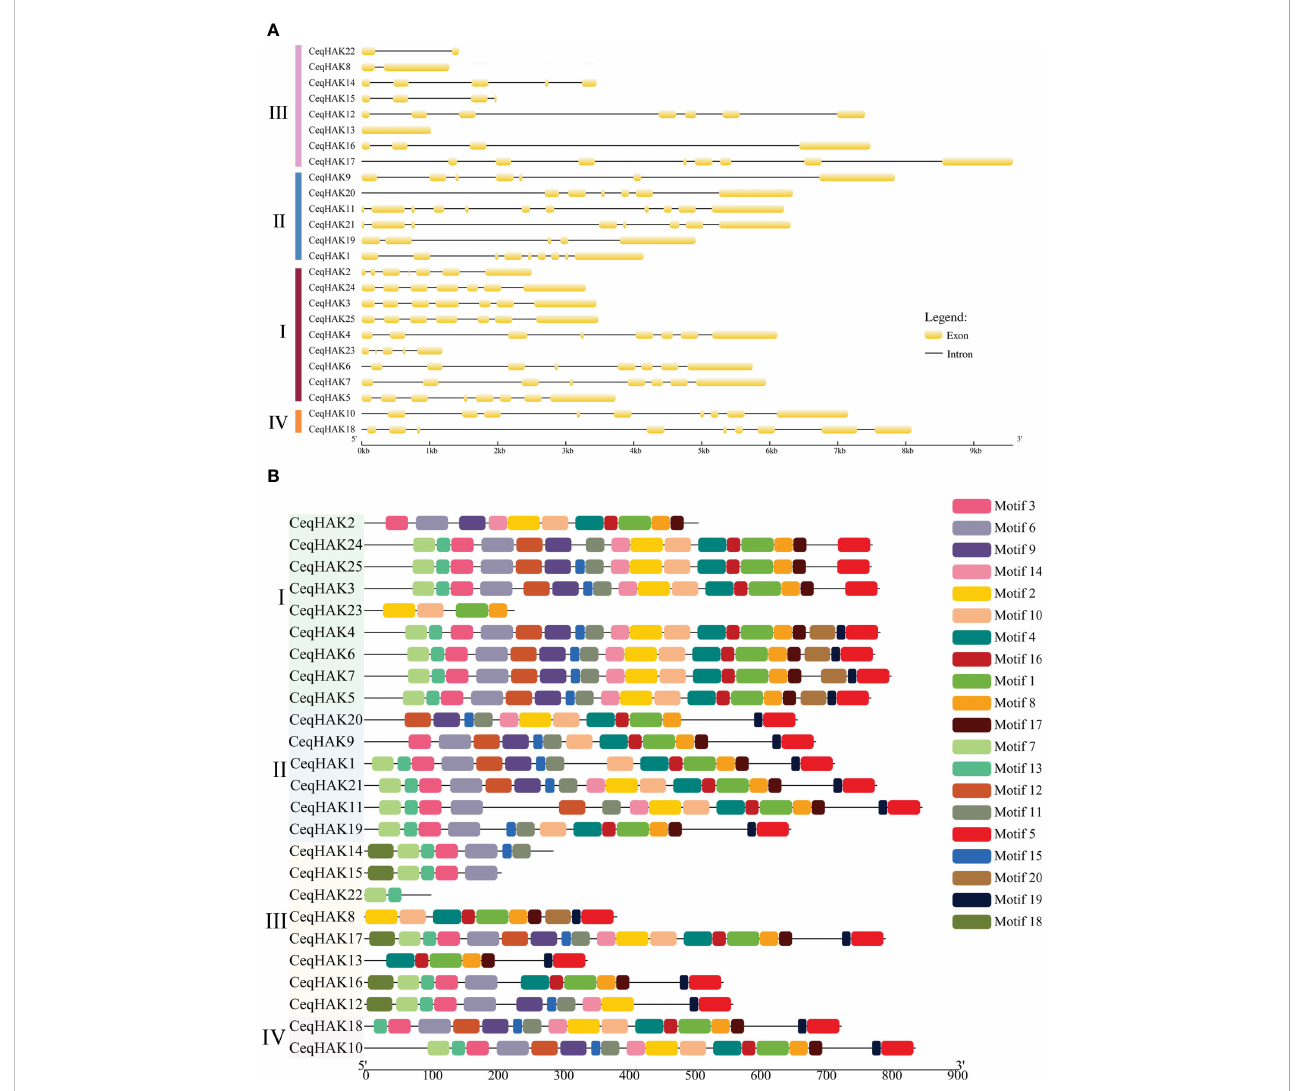
FIGURE 2 Gene structure and conserved motifs of HAK genes in C equisetifolia . (A) Gene structure analysis of CeqHAKs . Introns were depicted by black lines, and coding sequences were represented by yellow boxes. (B) Conserved motifs analysis of CeqHAKs . In different colored boxes, conservative motif numbers 1-20 are